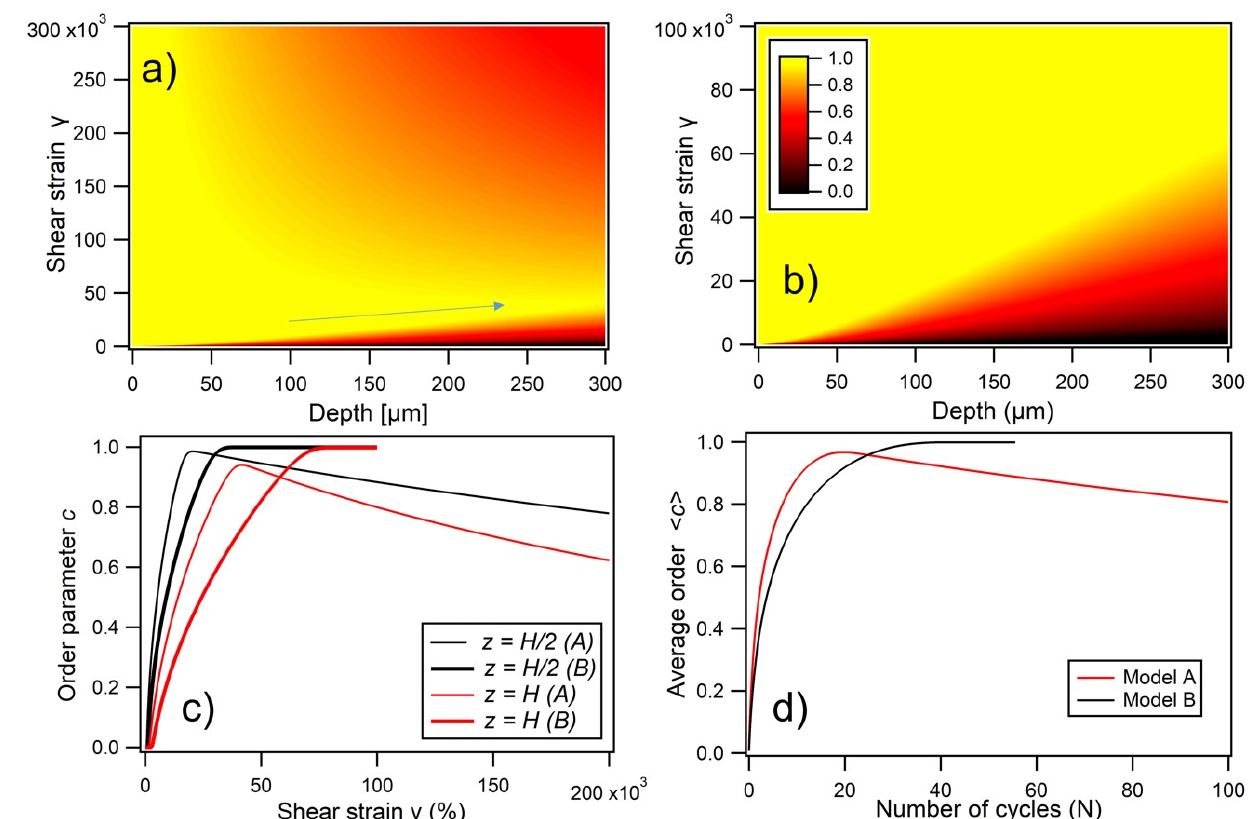
Figure 5. ( a ) Simulated nonlinear diffusion of crystal order into a sample with increasing total applied strain using Model A (degradation proportional to total applied strain), showing a gradual depth transition as illustrated by the arrow, followed by gradual disordering at high strains. The degradation constant κ has a notional value of 2.6 × 10 − 10 in this case. ( b ) Shows a comparative simulation using Model B (global shear-rate degradation), showing a gradual depth transition which replicates experimental observations. The degradation constant k has a value of 0.5 s in this case. In both ( a , b ), the simulation parameters were, strain amplitude = 150%, frequency = 1 Hz, and a common z-scale for the ordering parameter, c , is shown as an inset to ( b ). Comparing simulation models A and B, ( c ) shows how the order parameter varies at the cell midpoint ( z = H /2) and full depth ( H ) as a function of total applied strain. Commensurately, ( d ) shows how the order parameter, as spatially averaged across the 300 mm width of the sample, varies as a function of the number of BIOS oscillations